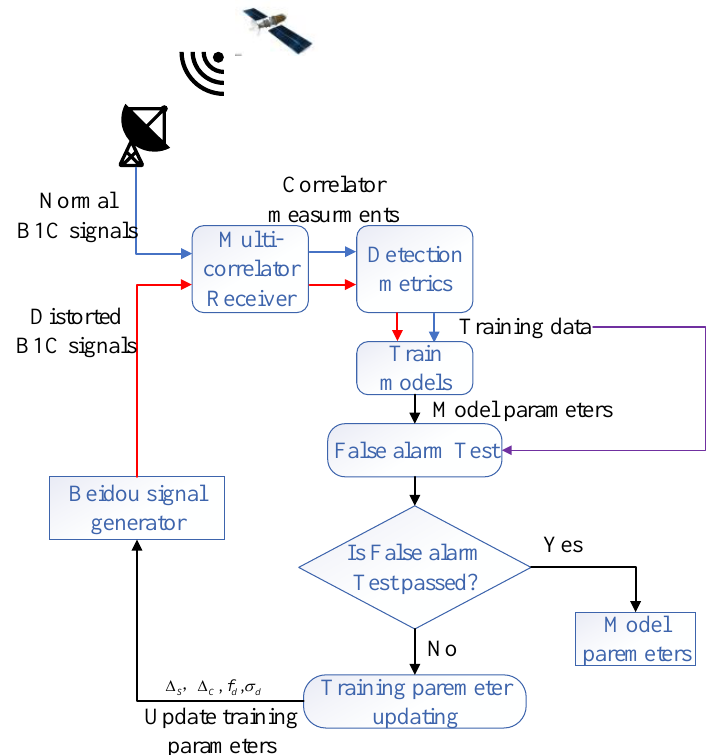
Figure 5. Selection process of training parameters.